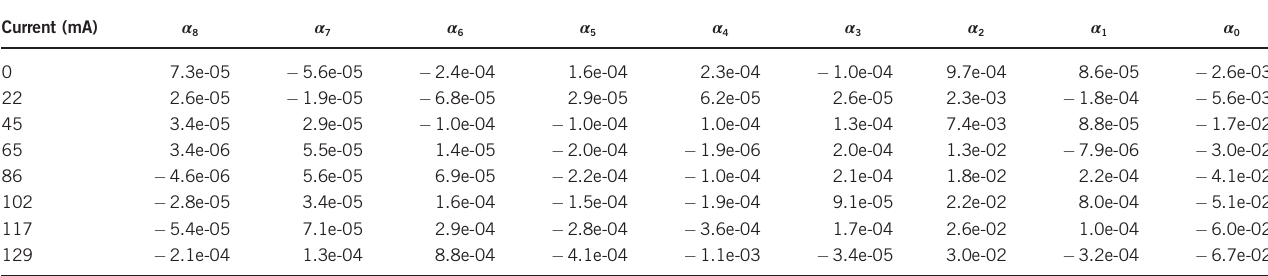
The current values are those of the magnetic actuator.